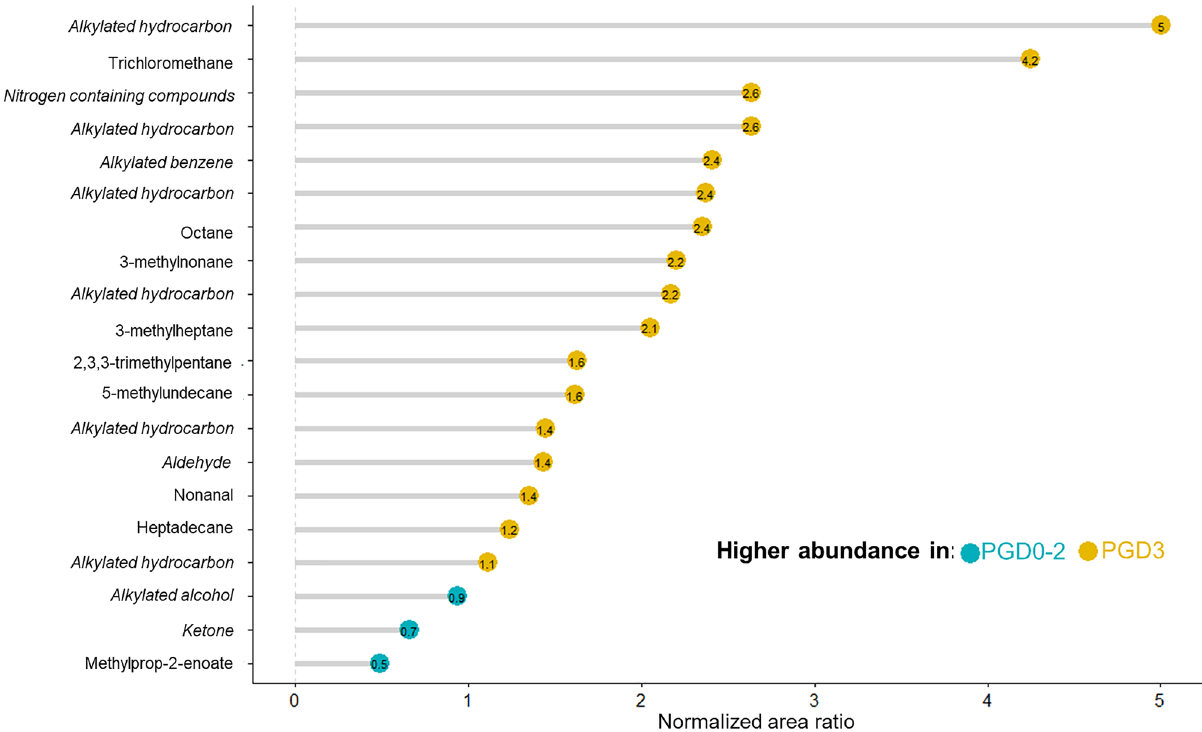
Figure 4. Ratio of normalized area of the 20 selected